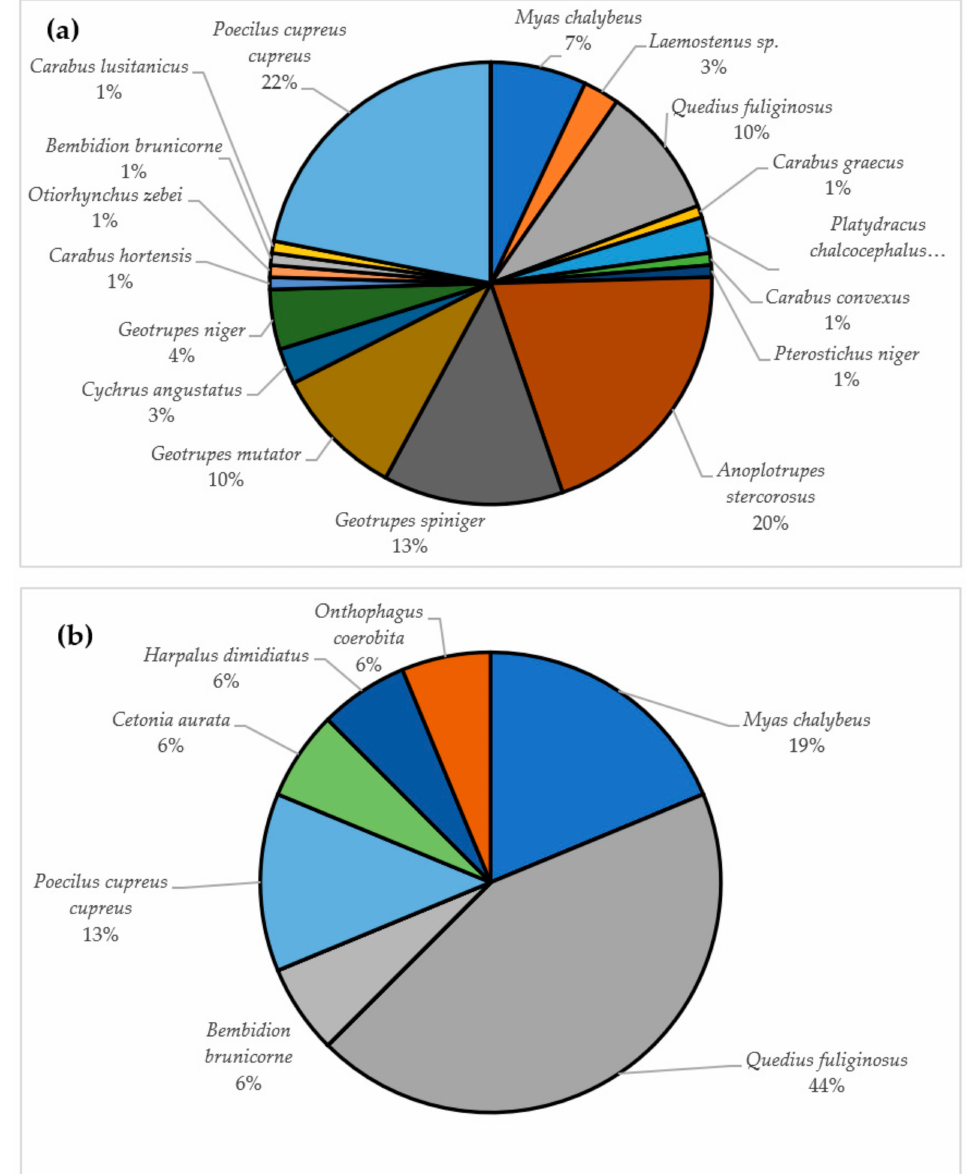
Figure 6. The ground-dwelling species composition in ( a ) Vathirema (VTR) and ( b ) Arkoudorema